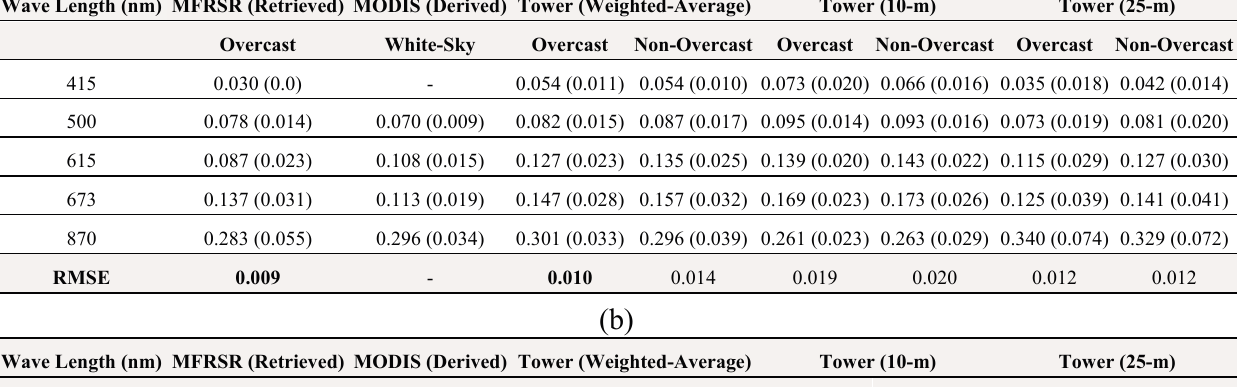
Wave Length (nm) MFRSR (Retrieved) MODIS (Derived) Tower